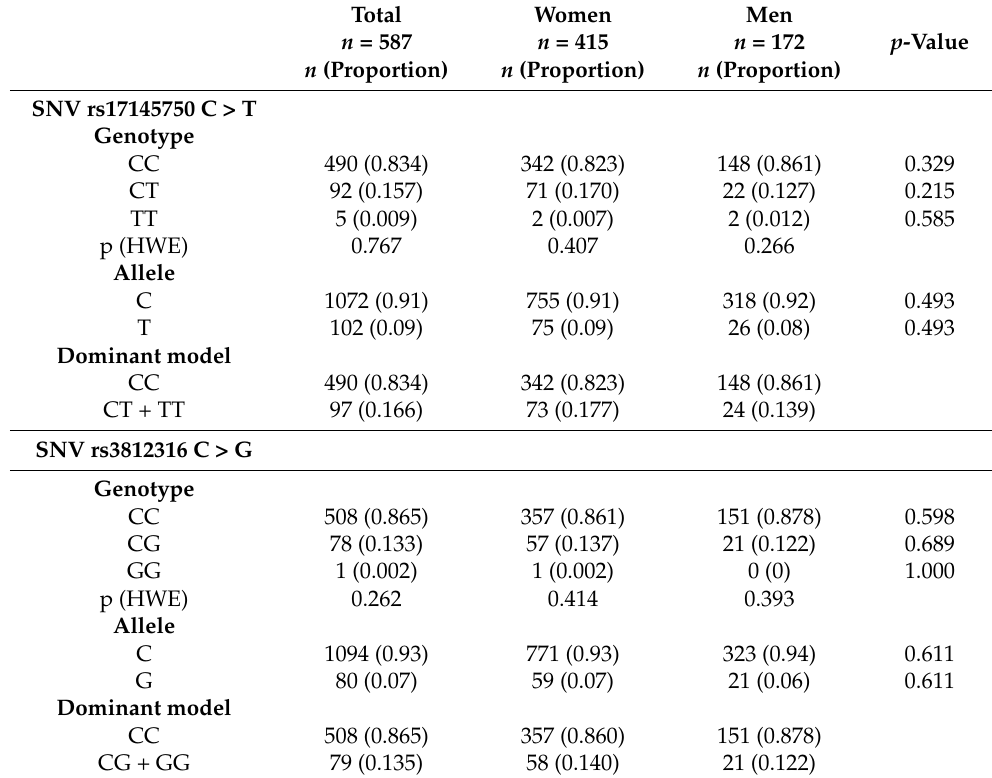
Table 3. Genotype and allelic frequencies of the rs17145750 and rs3812316 SNV’s of MLXIPL